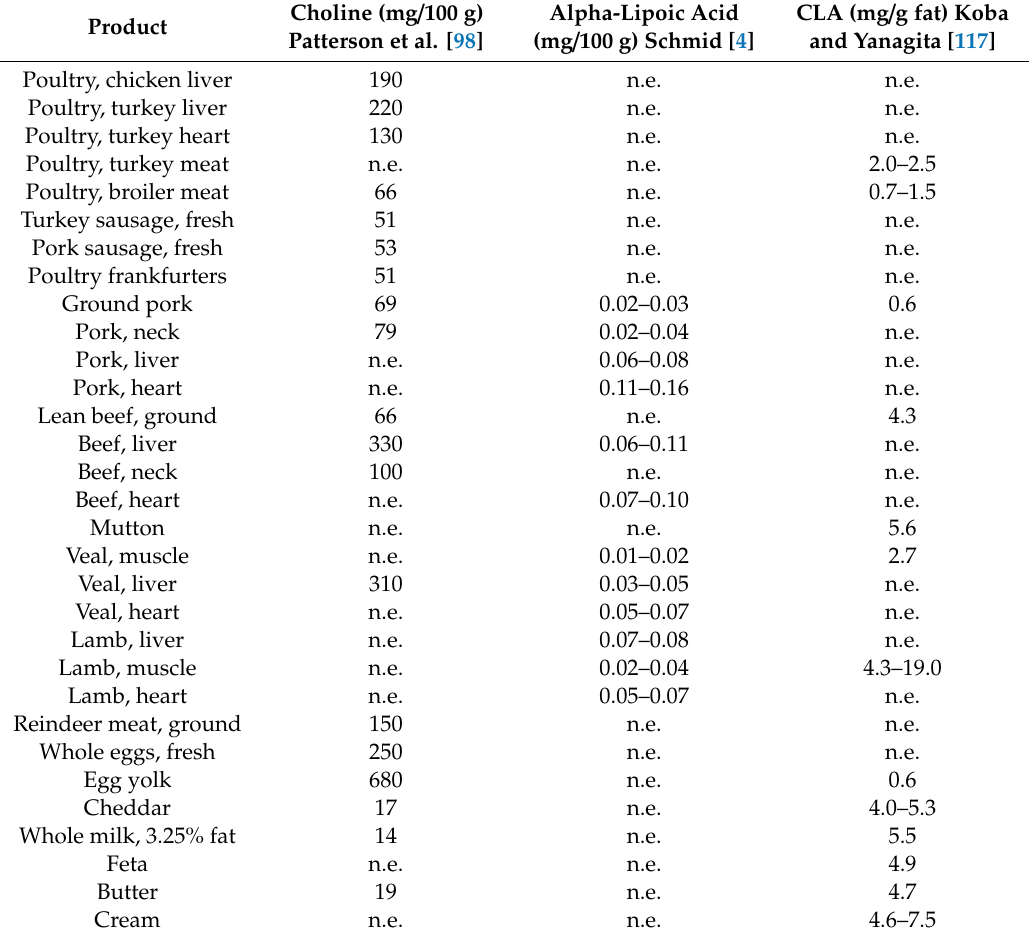
Table 5. Contents of choline, alpha-lipoic acid and conjugated linoleic acid (CLA) in meat and animal origin